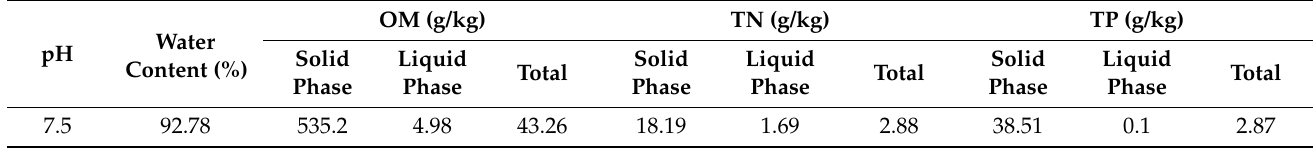
Table 1. Physicochemical properties of the CDS.